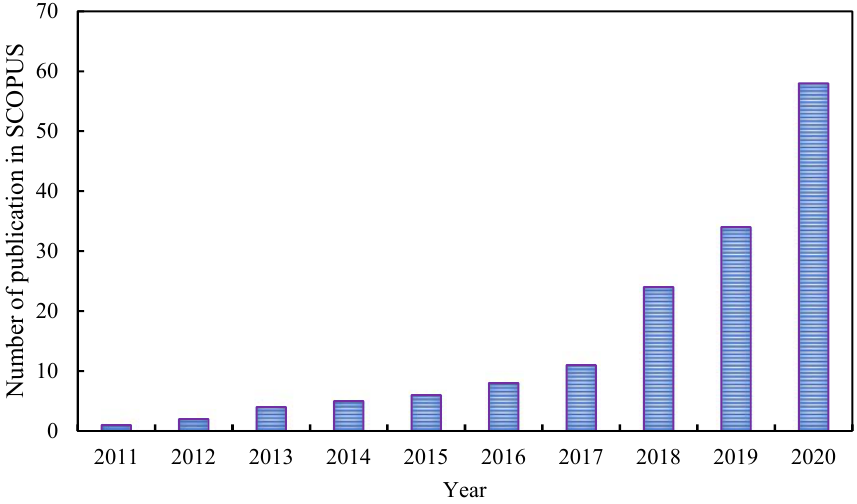
Figure 12. Number of works addressing integration of BIM and LCS in the Scopus database from 2011 to 2020.